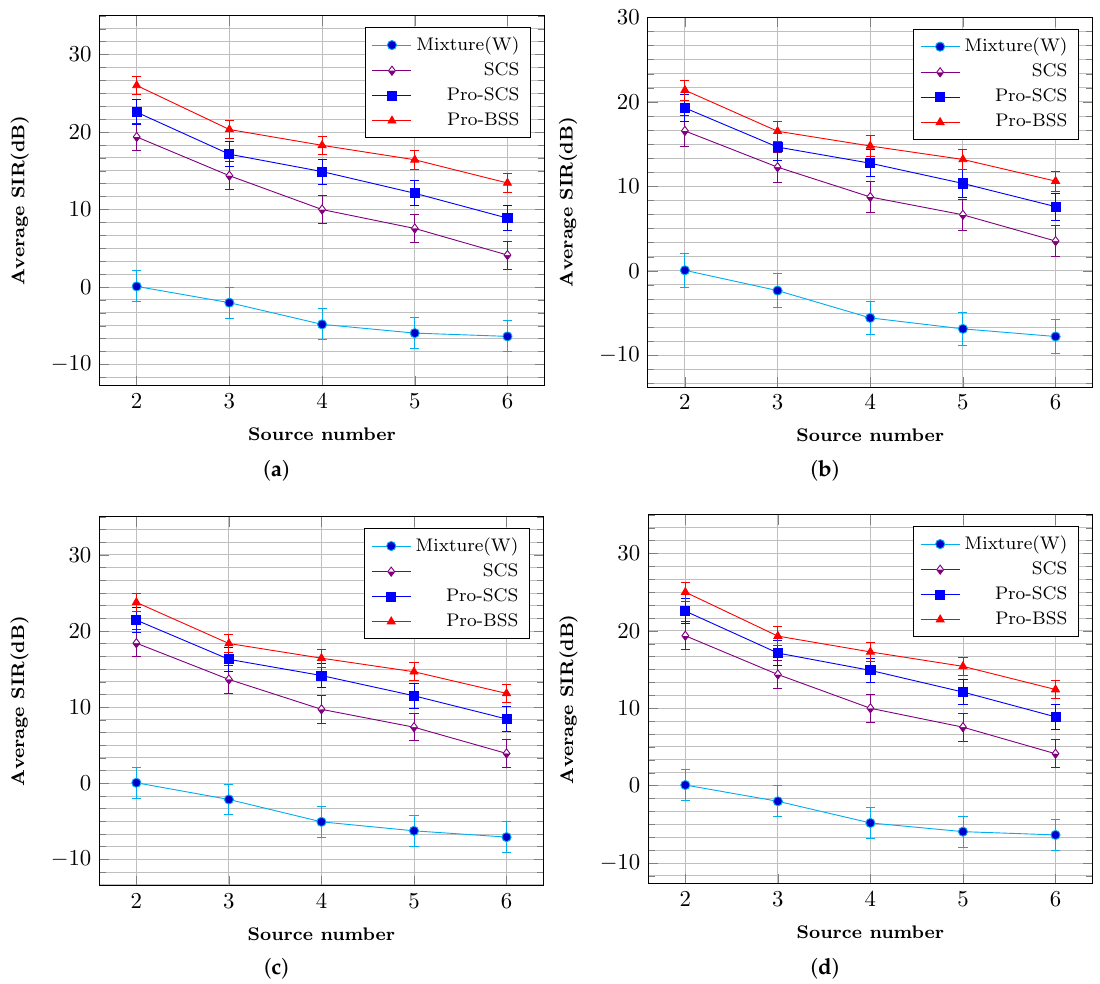
Figure 8. Signal-to-interference ratio (SIR) results. Error bars represent 95% confidence intervals; ( a – d ) represent the results for separations {30 ◦ , 40 ◦ , 50 ◦ , 60 ◦